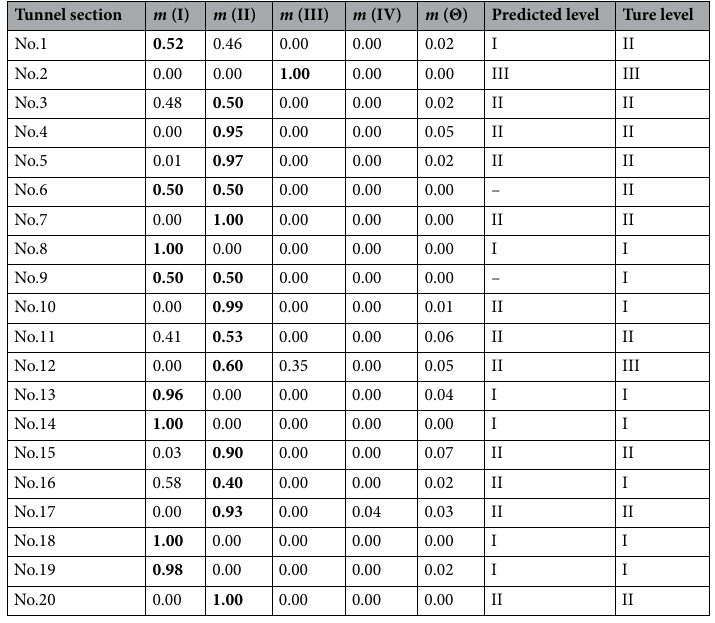
Table 7. Results of Cloud model at ten monitoring sections. Significant values are in